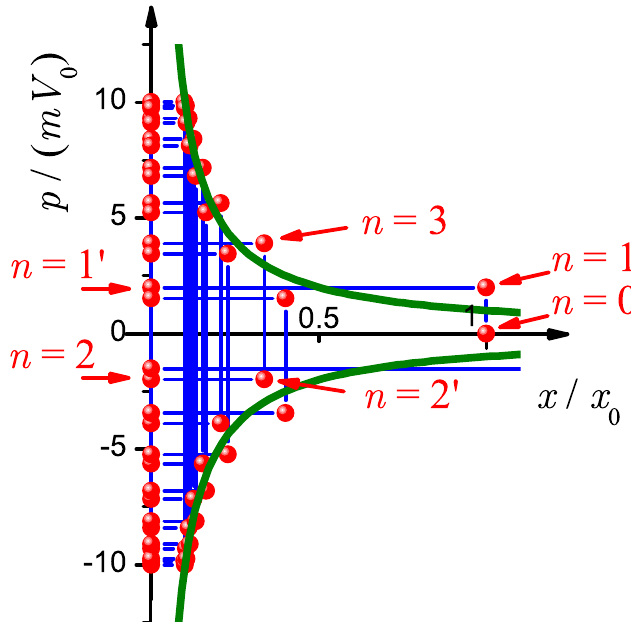
Figure 7. (x,p) portrait for b = 10 and N = 1; Red symbols, light particle during ball–wall ( x = 0) and ball–ball ( x (cid:54) = 0) collisions. Green thick lines, constant action curve defined by Equation (15). Blue thin lines, trajectory. Index n = 1,2,3, · · · denotes the state after n collisions while primed index n (cid:48) correspond to an intermediate state in which the velocity of the light ball is not yet reflected. The area covered by the trajectory between two consecutive collision of the same type (BB or BW) defines the action